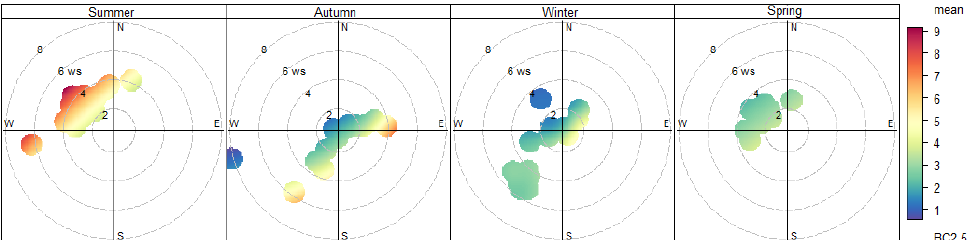
Figure 7. Polar plots of BC concentrations for four seasons (spring, winter, summer, and autumn) in the city of Kenitra. The average BC concentration (µg/m 3 ) is coded according to the color scale shown on the right. The dashed circular grey lines show the wind speed scale.